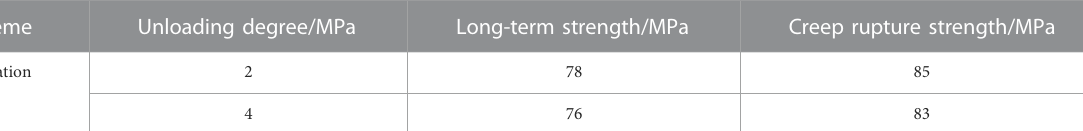
TABLE 3 Long-term strength of Flint limestone under unloading stress path.